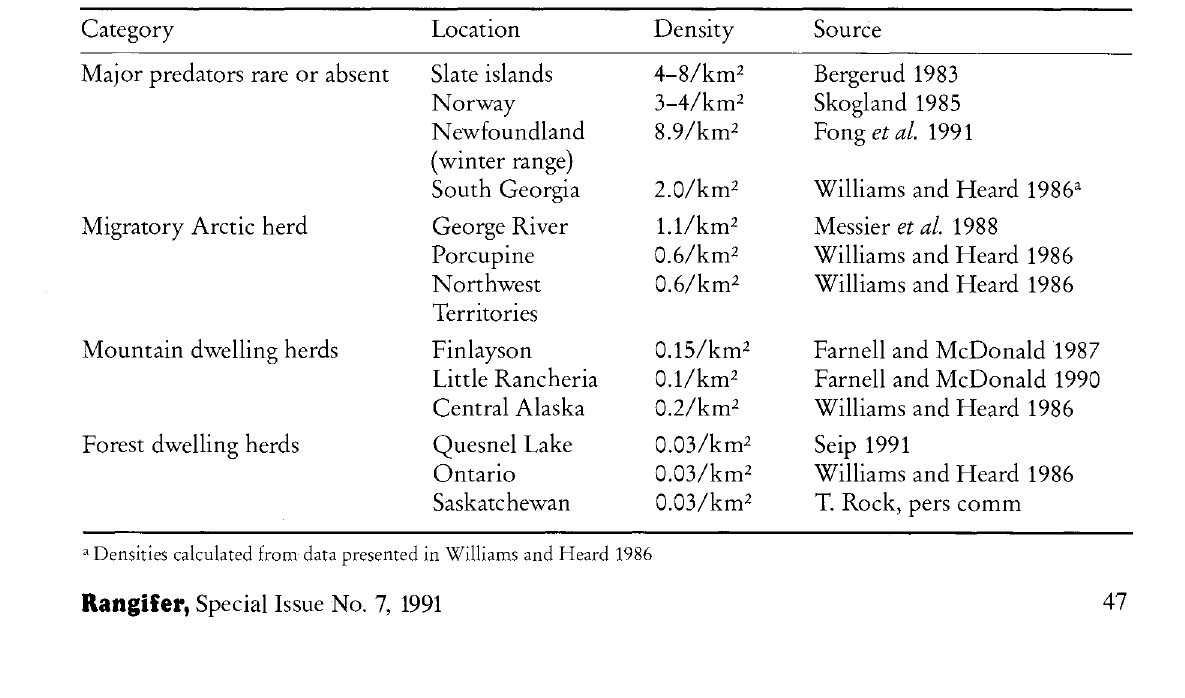
Table 1. Density of Rangifer populations in relation to the level of